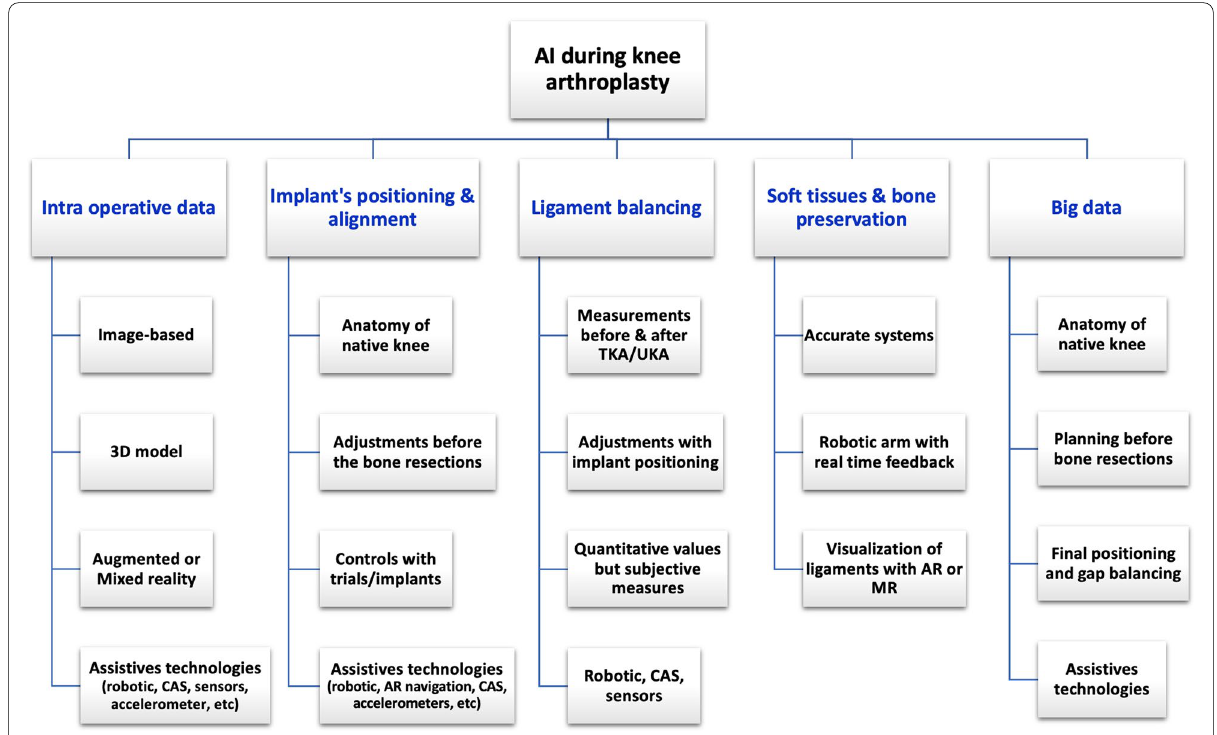
Fig. 3 Structure chart presenting the intraoperative major interests of AI